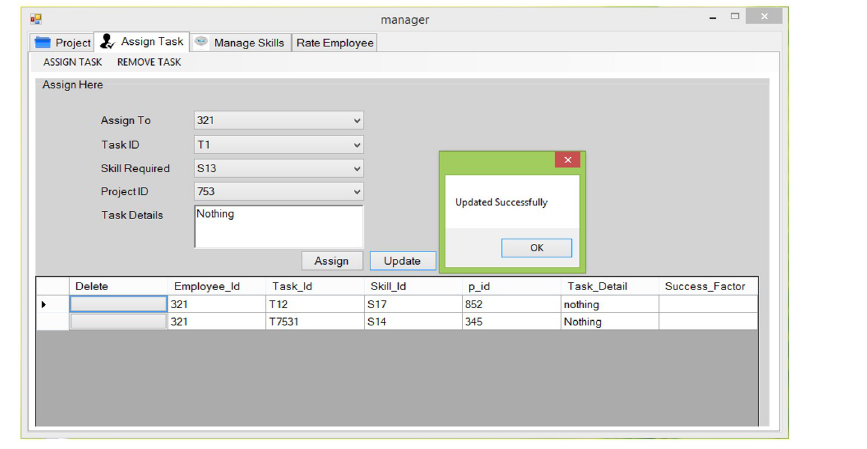
Fig 7. Assign tasks.